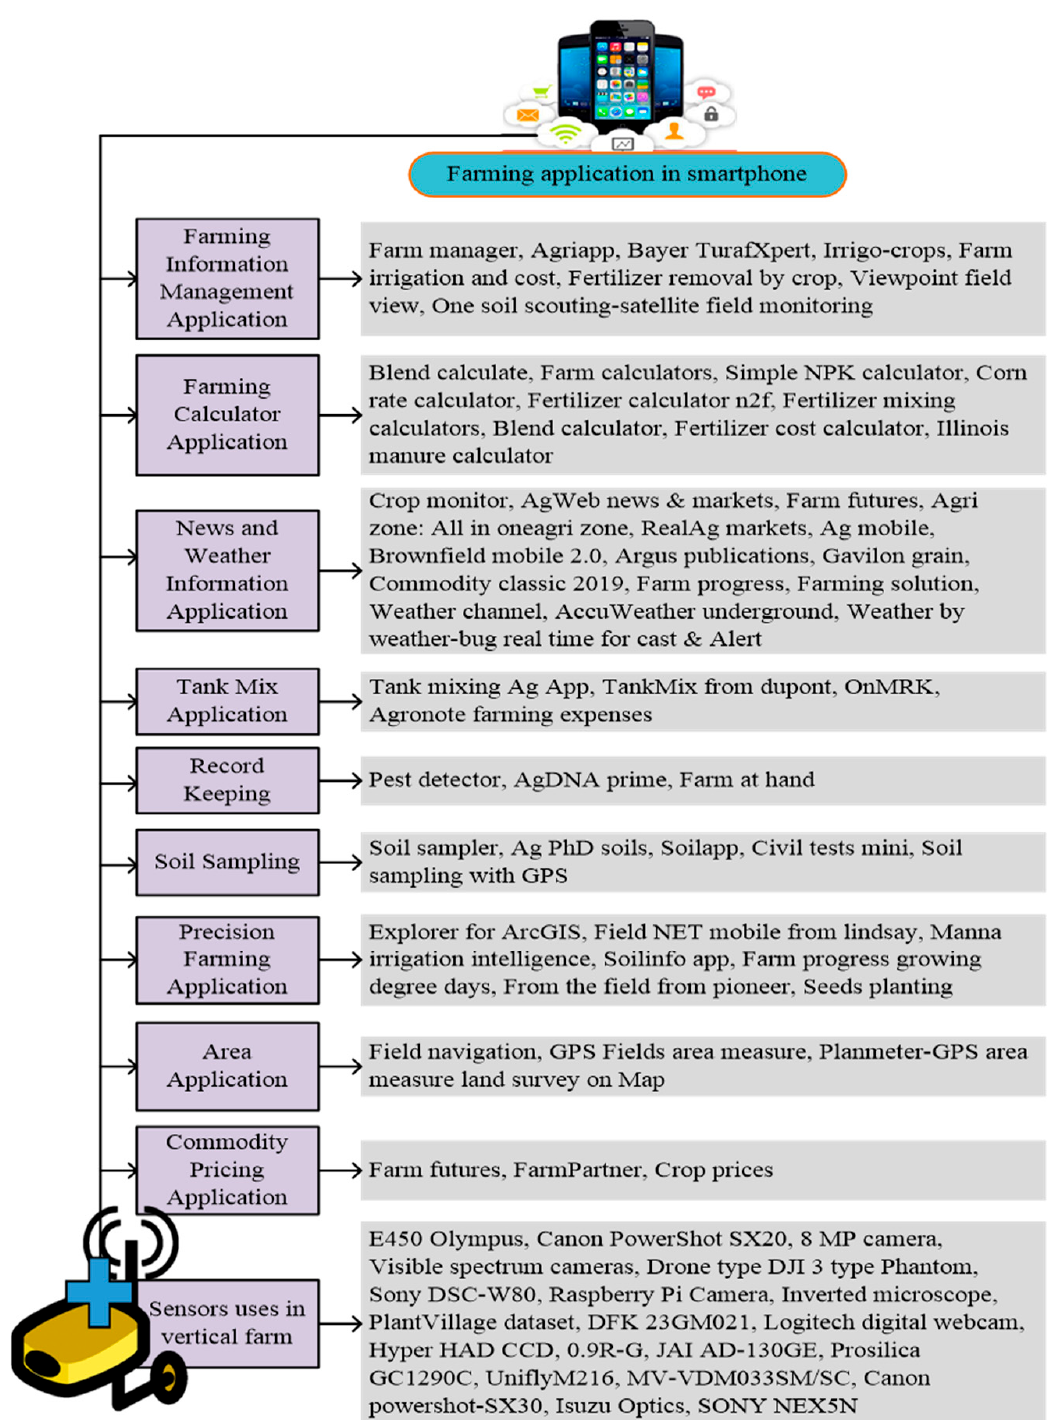
Figure 11. Smartphone applications and the camera model sensors for smart farming.